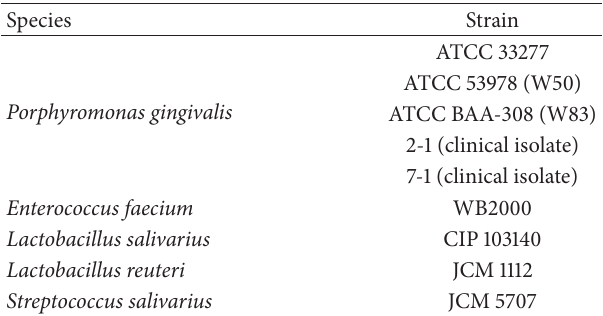
Table 1: Bacterial strains used in the study.